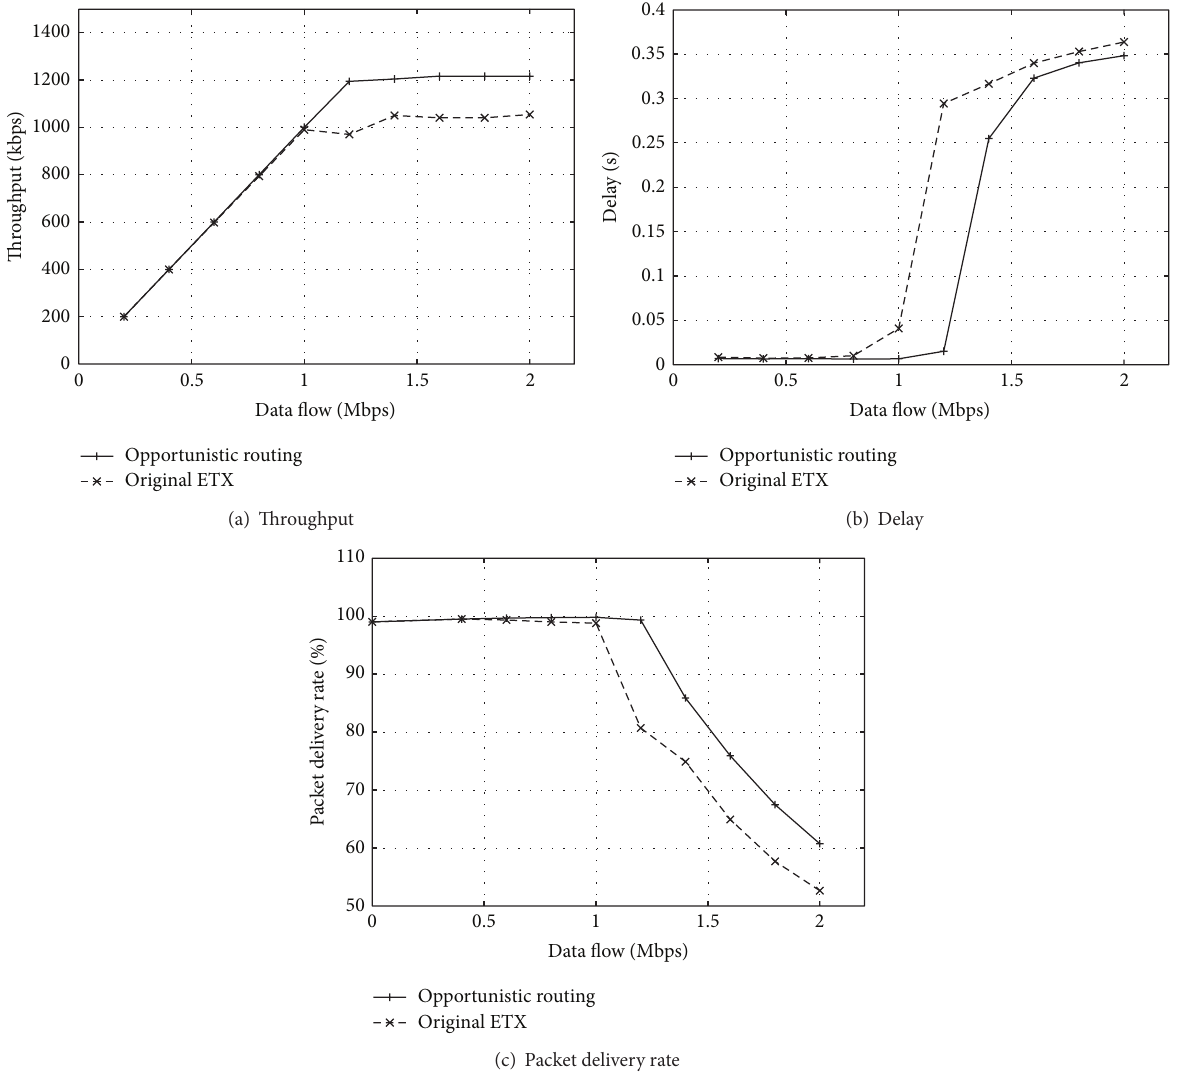
Figure 6: Performance comparison with different data